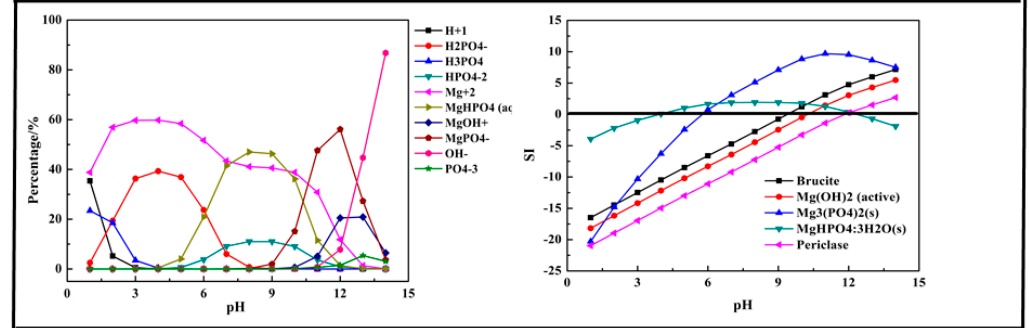
Figure 4. Percentage of species in the Mg-P-H 2 O system at 298 K at ranged pH ((P) = 0.01 mol/L, (Mg 2+ ) = 0.015 mol/L).